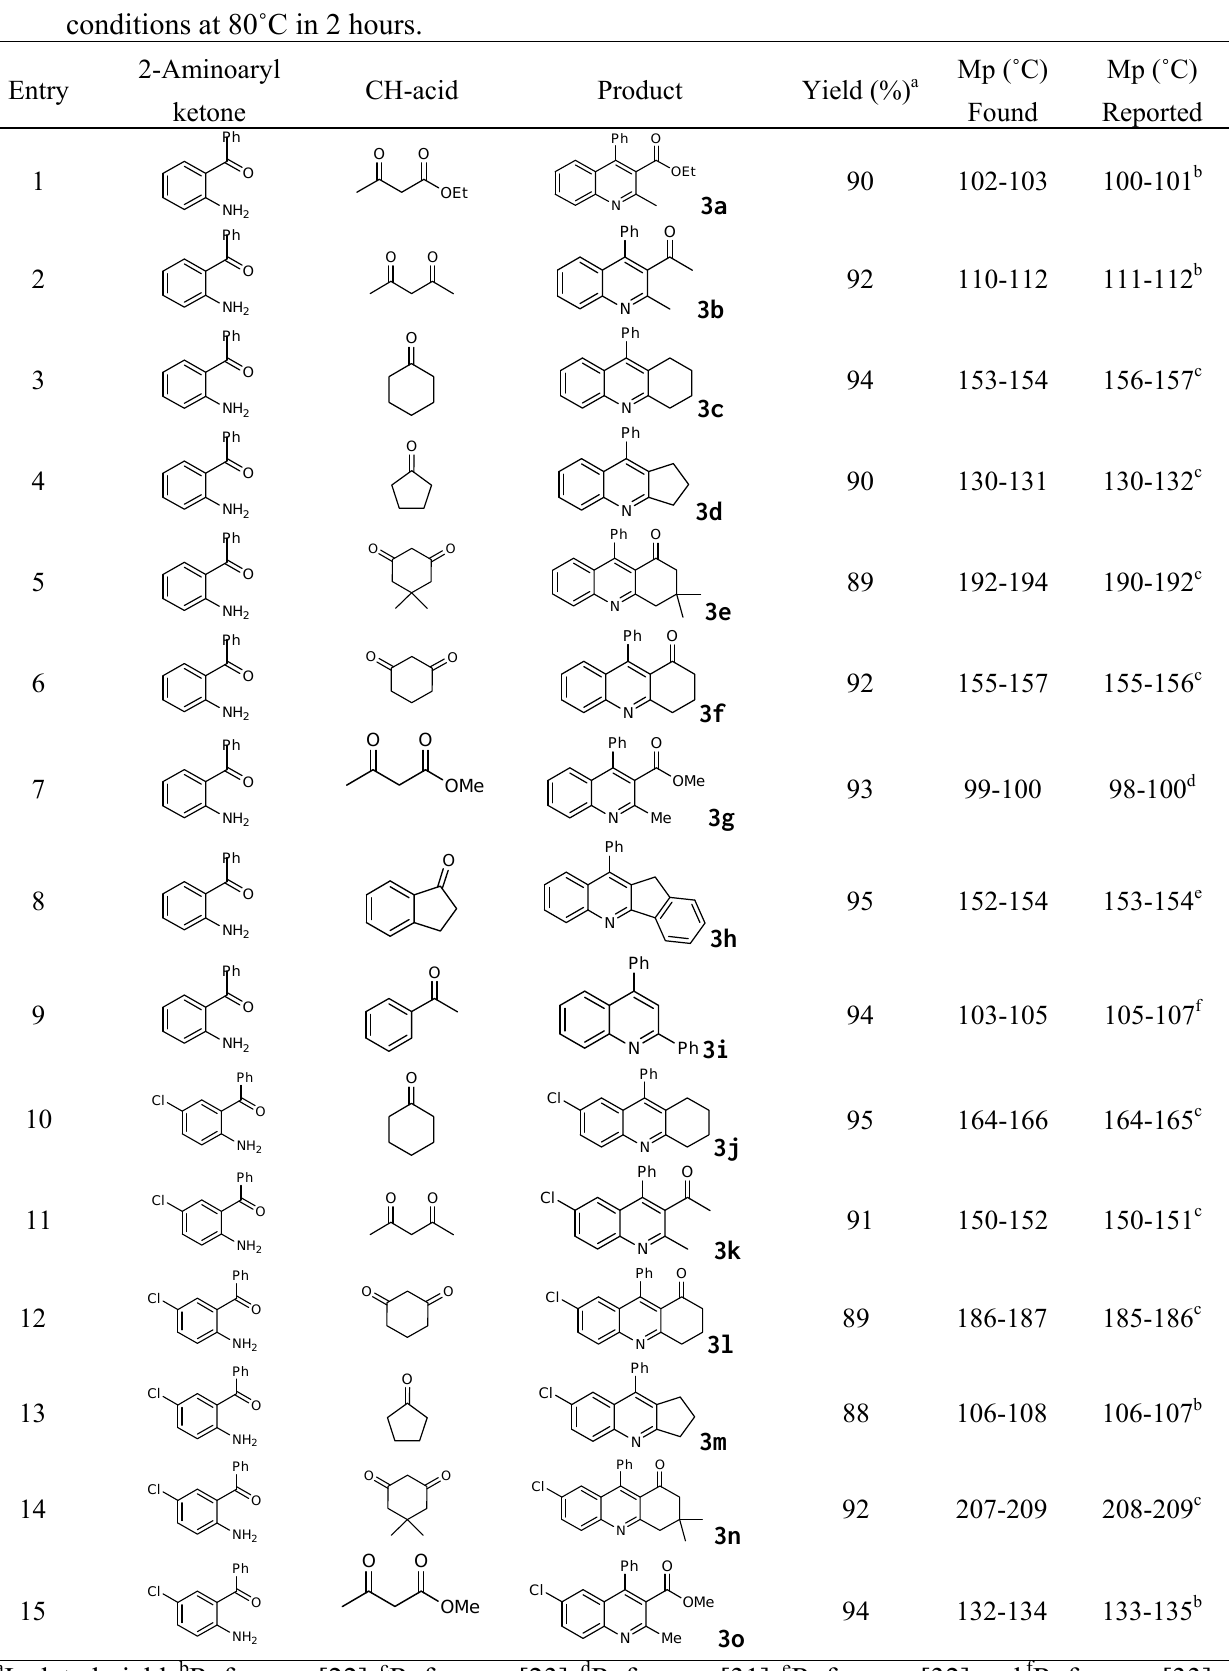
PW O under solvent-free 3 12 40